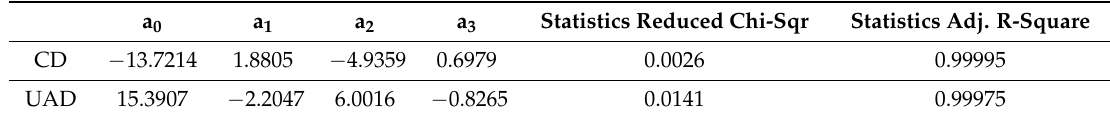
Table 6. Cutting torque T 1 from CD and UAD